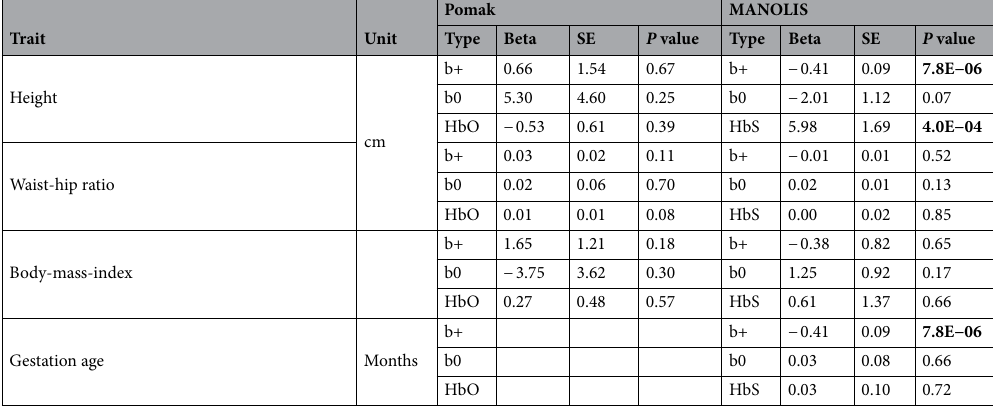
Table 3. Differences in haematological, cardiometabolic and anthropometrics traits between carriers and non-carriers of HBB mutations. width RDW-SD in Pomak, RDW-a in Manolis. We grouped HBB mutations into those that either reduce (b +) or abolish (b0) expression of beta-globin (see Table 2). We also separated c.364C>A (HbO-Arab) in Pomak and sickle cell HbS in MANOLIS. Associations significant after Bonferroni correction ( p value < 0.0013) were